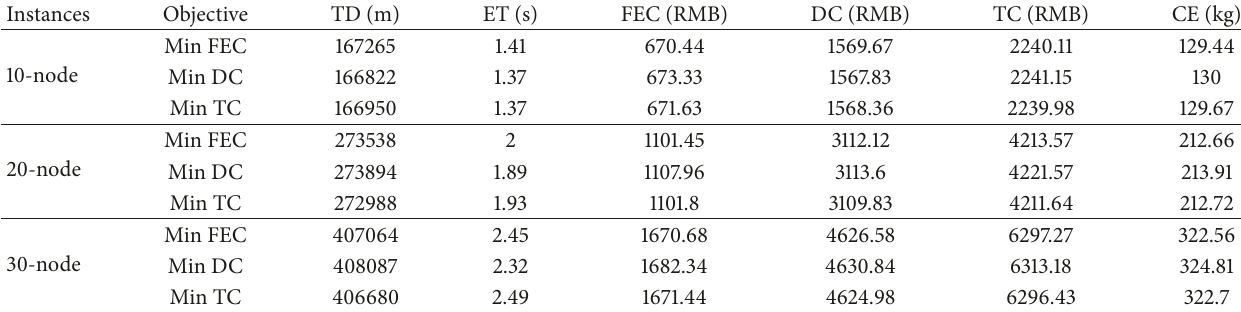
Table 7: Cost components with different